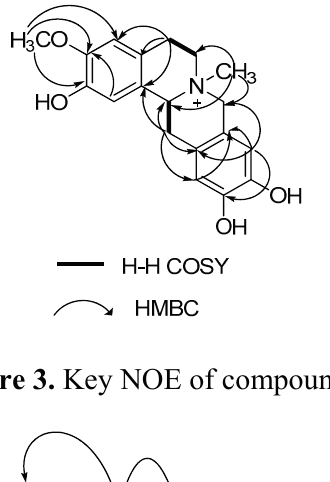
Figure 2. 1 H- 1 H COSY and key HMBC correlations of compound 1 .